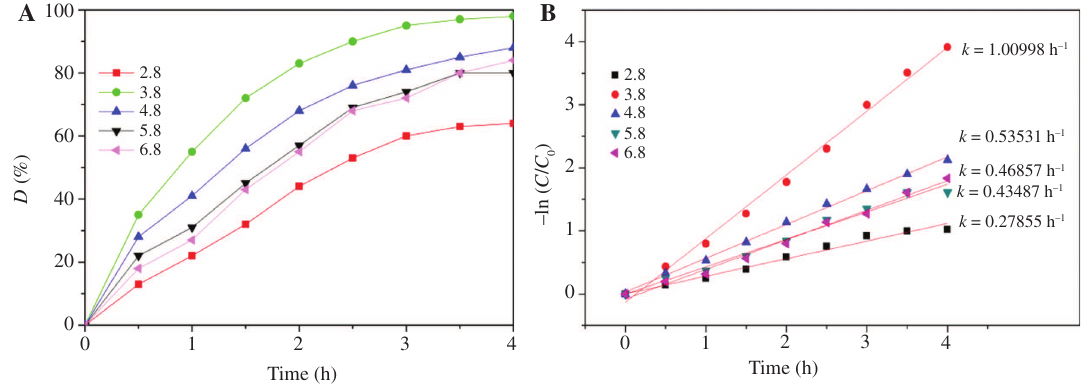
Figure 10: Map (A) and kinetic plot (B) of the degradation of MO with Cu 2 O/ZnO (sample II) with different pH (catalyst 0.1 g; initial concentration of MO 100 mg/l).